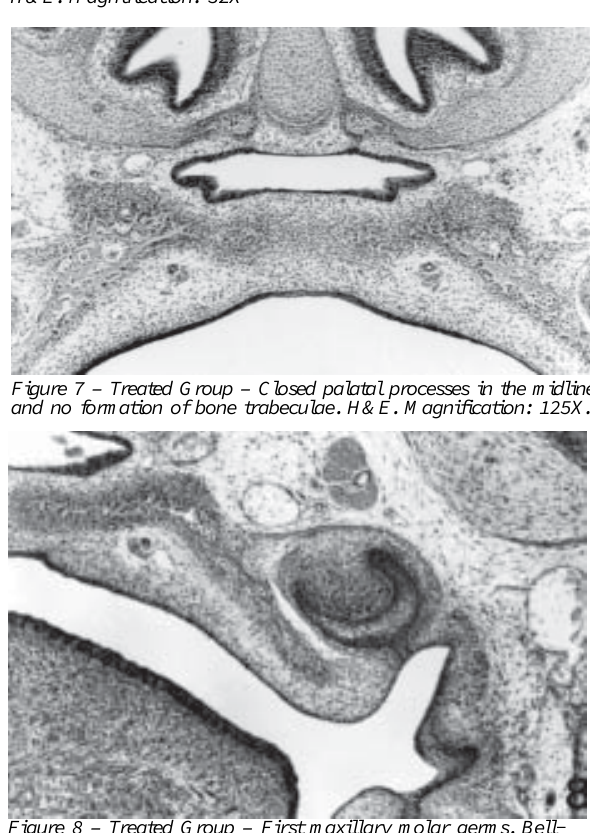
Figure 8 – Treated Group – First maxillary molar germs. Bell- shaped phase. H&E. Magnification: 125X.